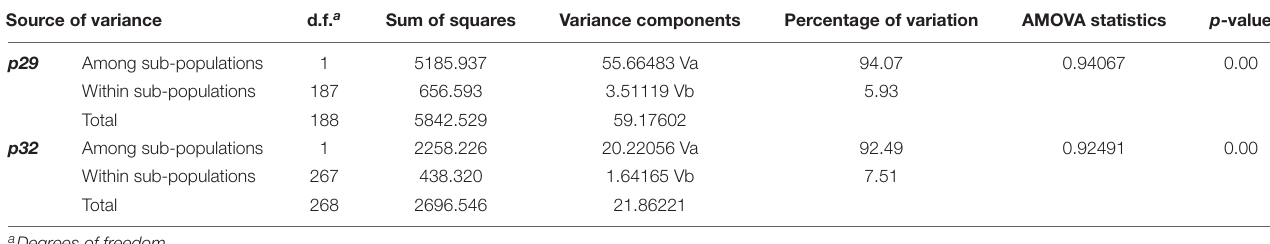
TABLE 7 | Analysis of molecular variance (AMOVA) for CiLV-C sub-populations of the clades CRD and SJP, based on ORFs p29 (795 nts) and p32 (288 nts, partial). Source of variance